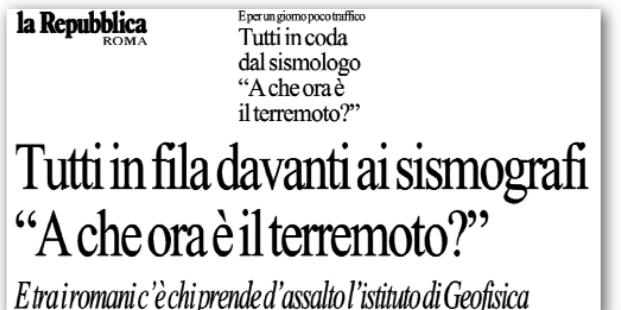
Figure 7. The headline of the daily national newspaper “La Repubblica” that appeared the day after the Open Day on May 11, to testify the extent and the effect of the initiative: “All lined up in front of the seismograph: ‘What time is the earthquake?’ And among the inhabitants of Rome, there are those who invade the Institute of Geophysics” [Erba